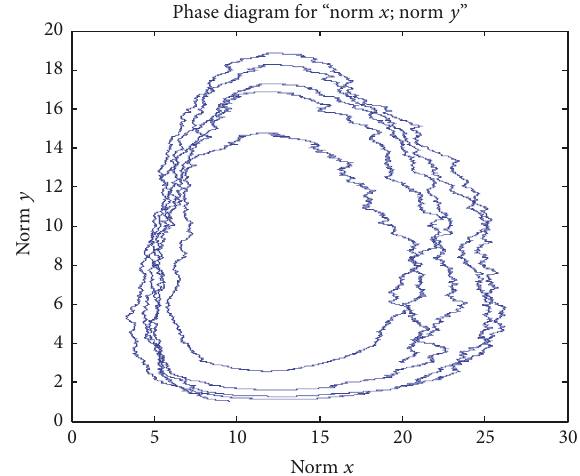
that at each time moment 𝑡 ∈ [0, 𝑇/√𝜀] the centered second moments of the process {𝑥 𝜀 (𝑡), 𝑦 𝜀 (𝑡)} can be approximated using the second moments of the process {𝑋(𝑡), 𝑌(𝑡)} in the form of asymptotic